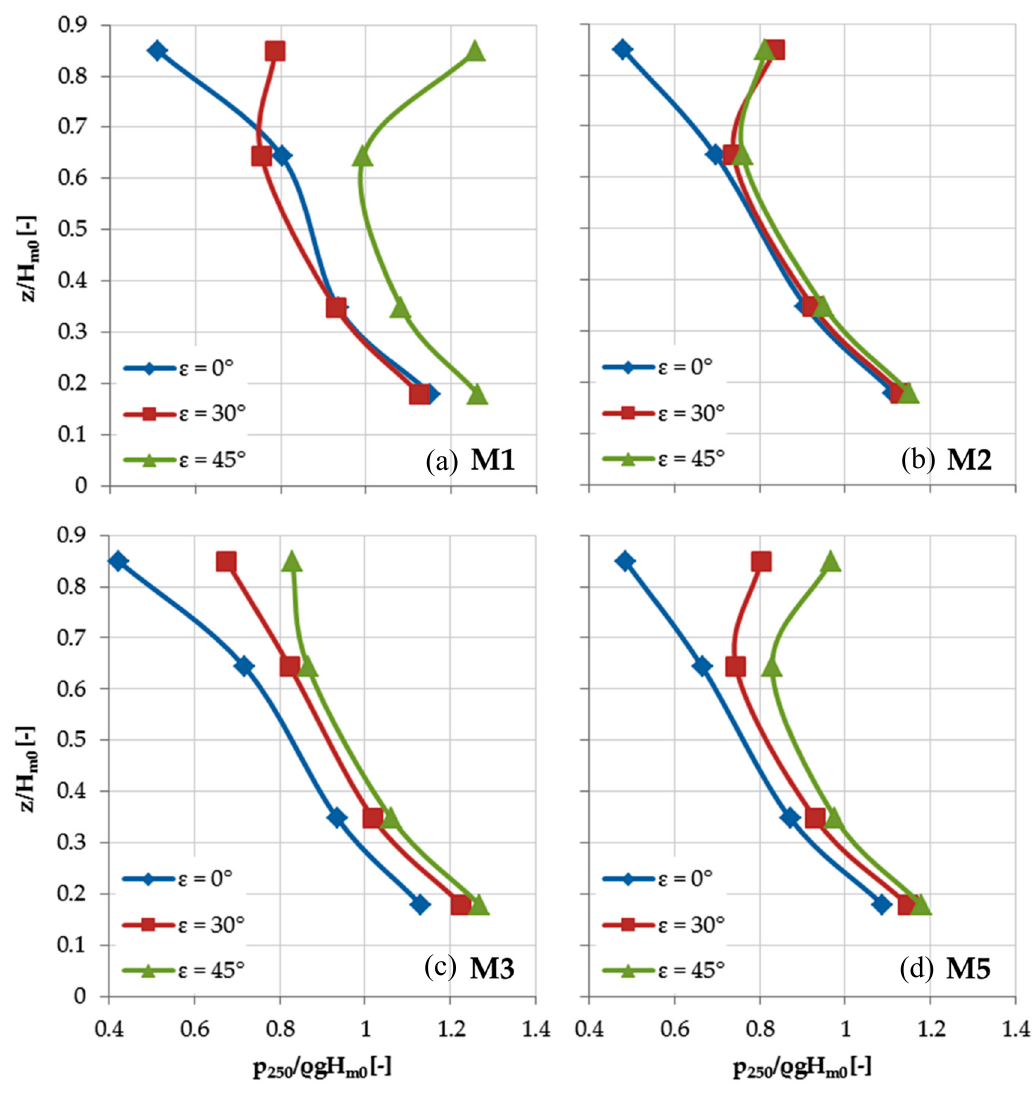
Figure 11. The non-dimensional pressures on the crown wall for the configurations ( a ) M1, ( b ) M2, ( c ) M3 and ( d ) M5. The vertical distances from the bottom (z) rather than the wave height (H m0 ) are reported on the ordinate, while the statistical values of p 250 divided by the wave height (H m0 ), the density ( ρ ) and the gravitational acceleration (g), on the abscissa.